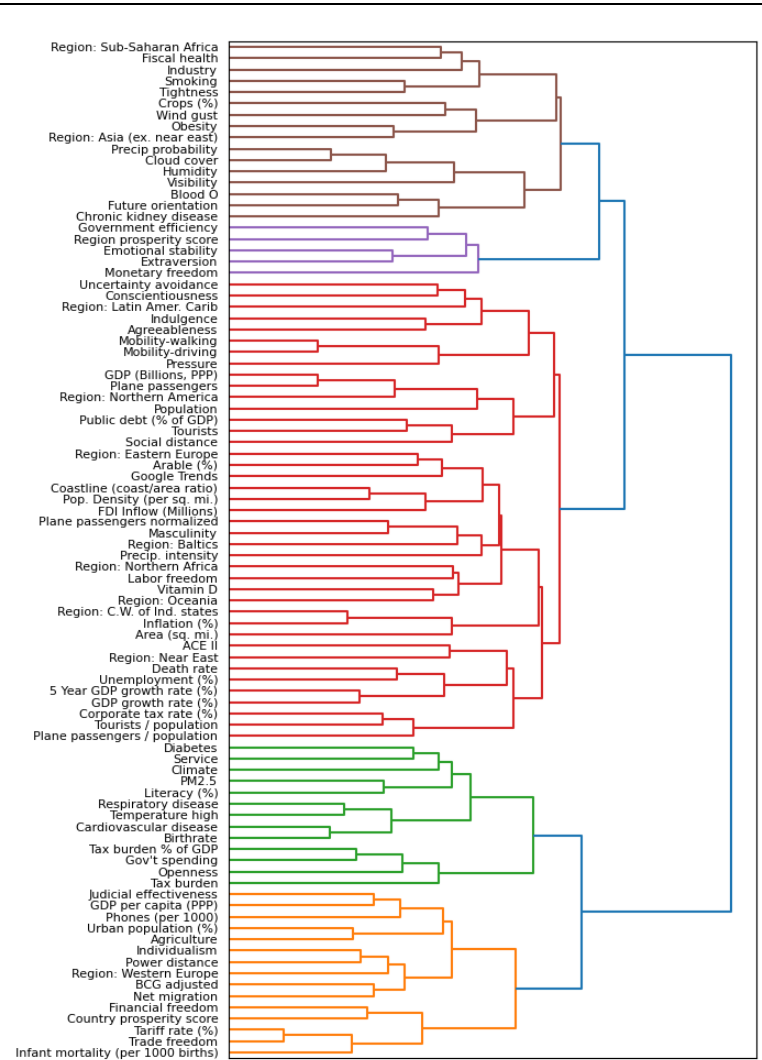
Figure A1. A dendrogram of features, connected based on the strength of their correlation, created with hierarchical